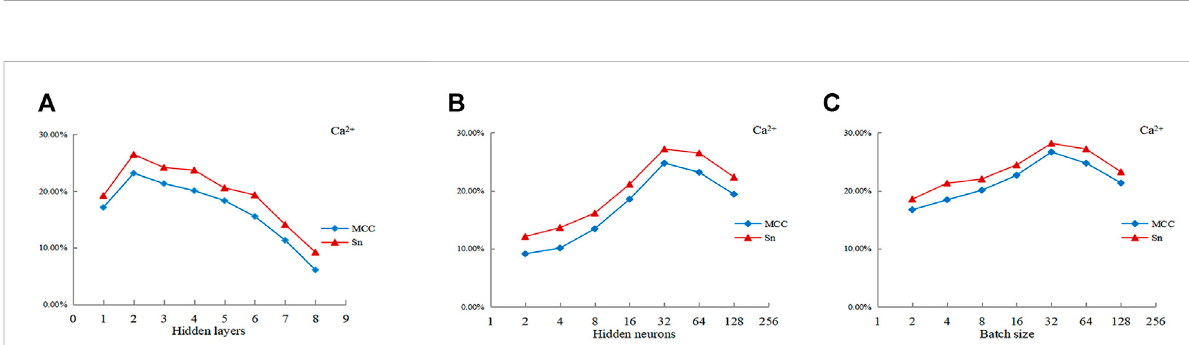
FIGURE 5 Curve of MCC value and S n value of Ca 2+ ligands with hyper-parameters. Note: The abscissas of (A-C) represent three hyperparameters, respectively. The ordinate is the value of MCC and S n ; MCC and S n are the evaluation index.